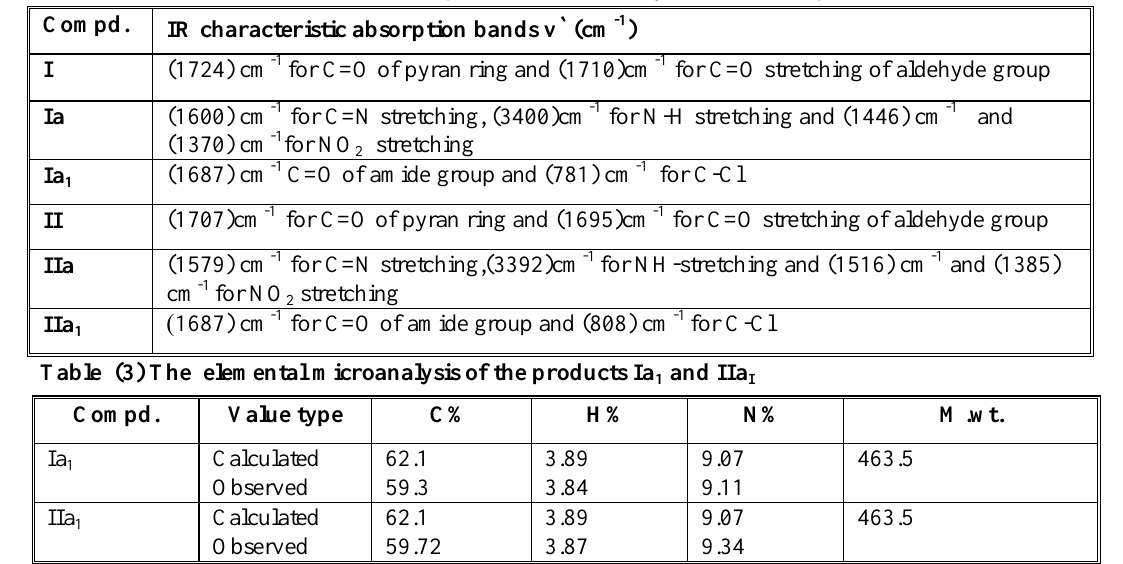
Table (3) The elemental microanalysis of the products Ia